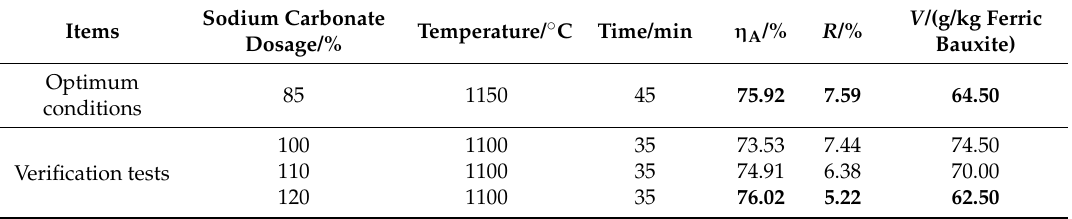
Table 7. Verification of restraining method on sodium volatilization and alumina